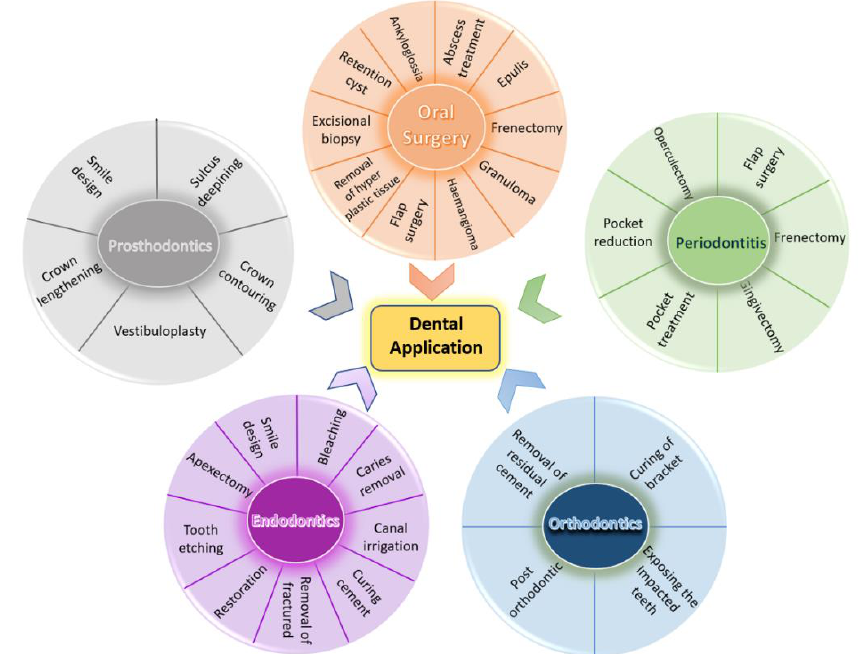
Figure 1. Dental applications of laser in the modern era in according to specialty.